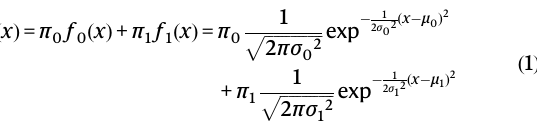
Fig. 7 | In vitro validation of site-979-speci fi c core fucosylation of L1CAM is a potential regulator of HCC metastasis. a Western blot of L1CAM levels in 97L cells overexpressing control vector, pL1CAM-FLAG vector or pL1CAM